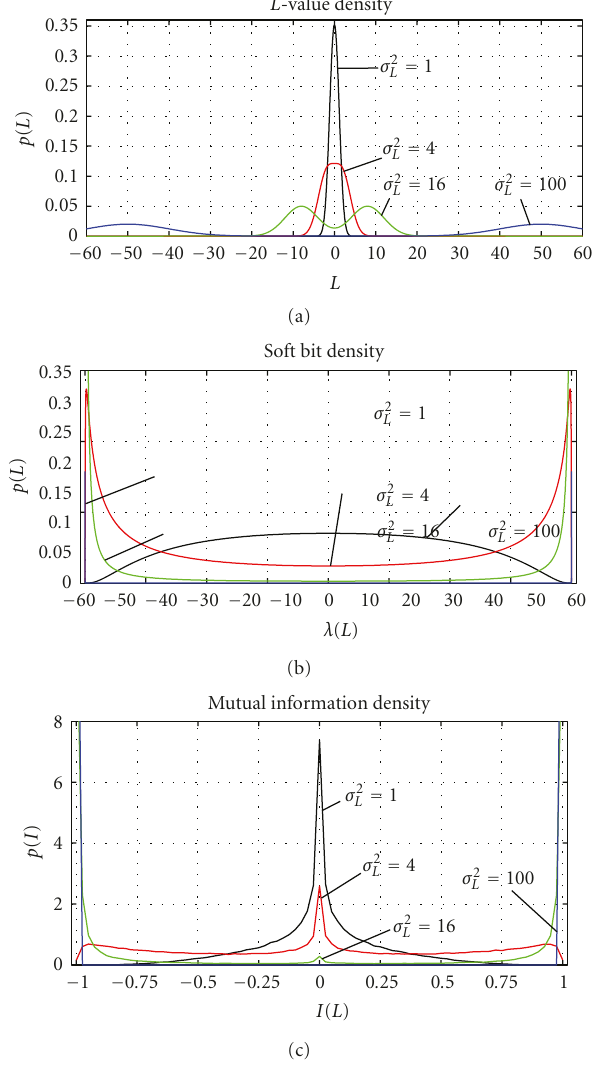
Figure 4: Comparison of the distribution of L -values represented in the original bimodal Gaussian form (a) or by soft bits (b) or mutual information (c).